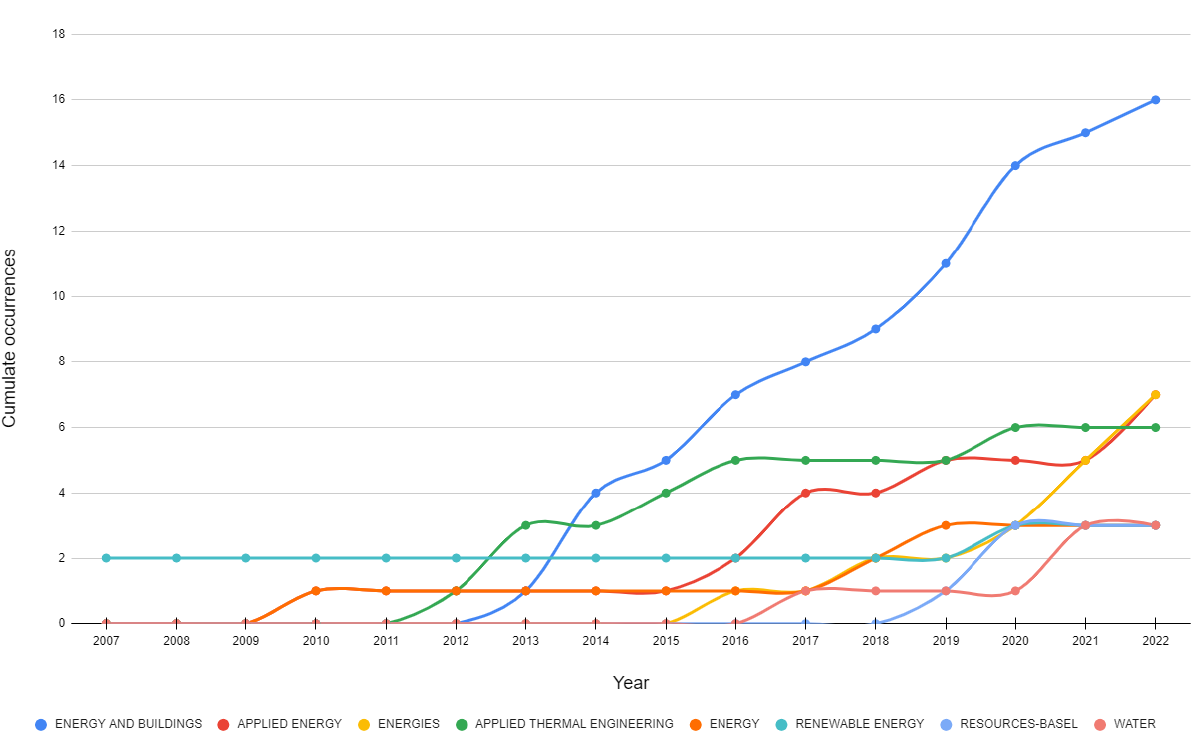
Table 7. The most cited research papers on greywater energy recovery.